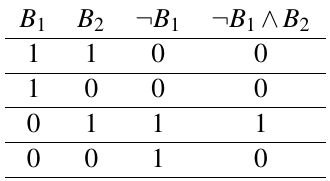
Table 3. Value table for contribution